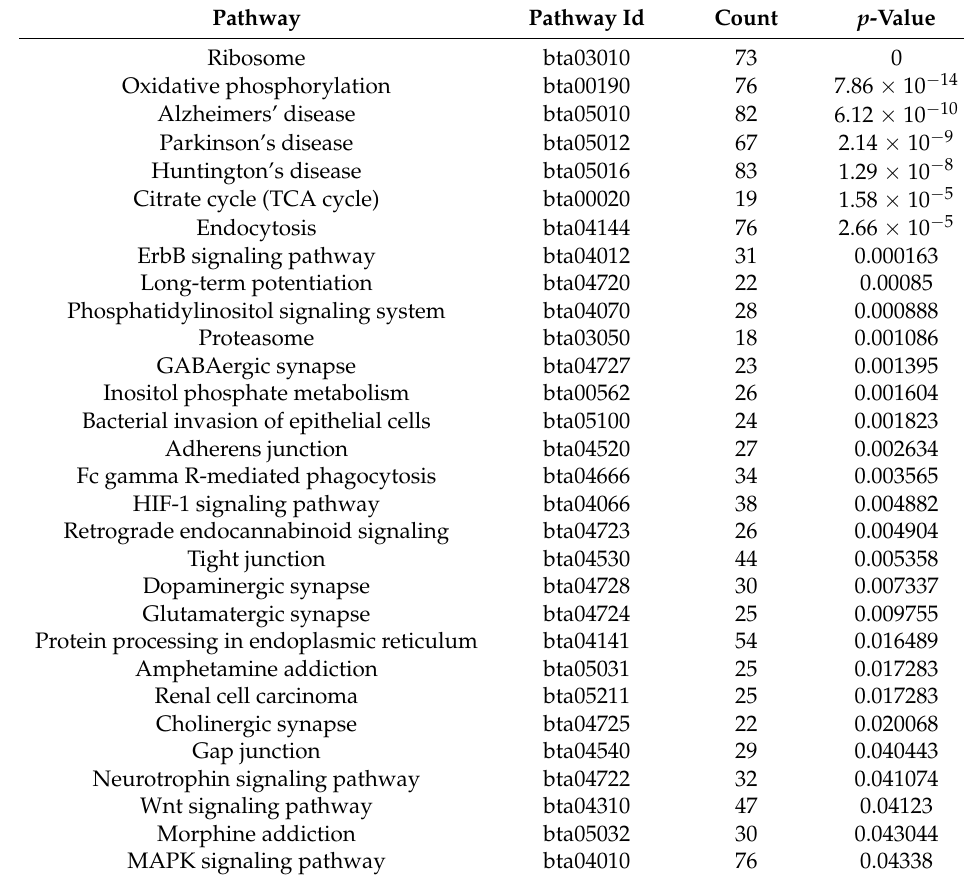
Table 2. Enriched pathways of differentially expressed genes